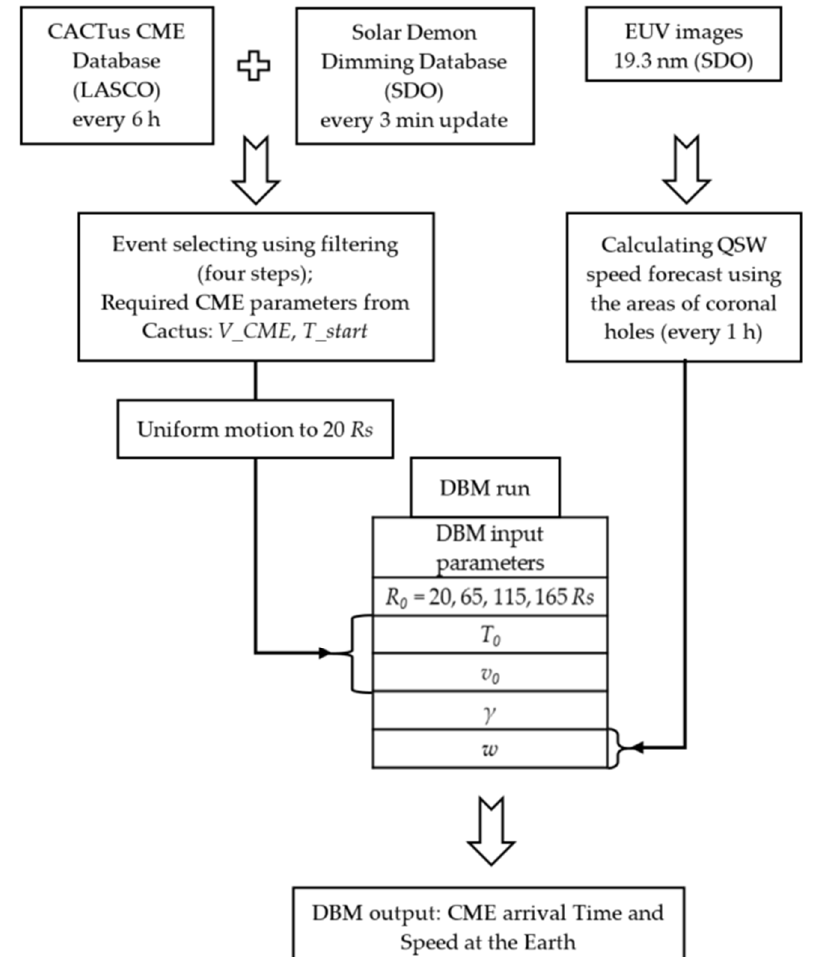
Figure 2. Scheme of the basic SMDC forecasting system. V_CME and T_start are the CME parameters obtained from the CACTus database, Rs is the solar radius, R 0 is the distance to which the DBM input parameters are recalculated. T 0 and v 0 are the CME parameters at 20 Rs , w is the ambient SW speed, γ is a drag